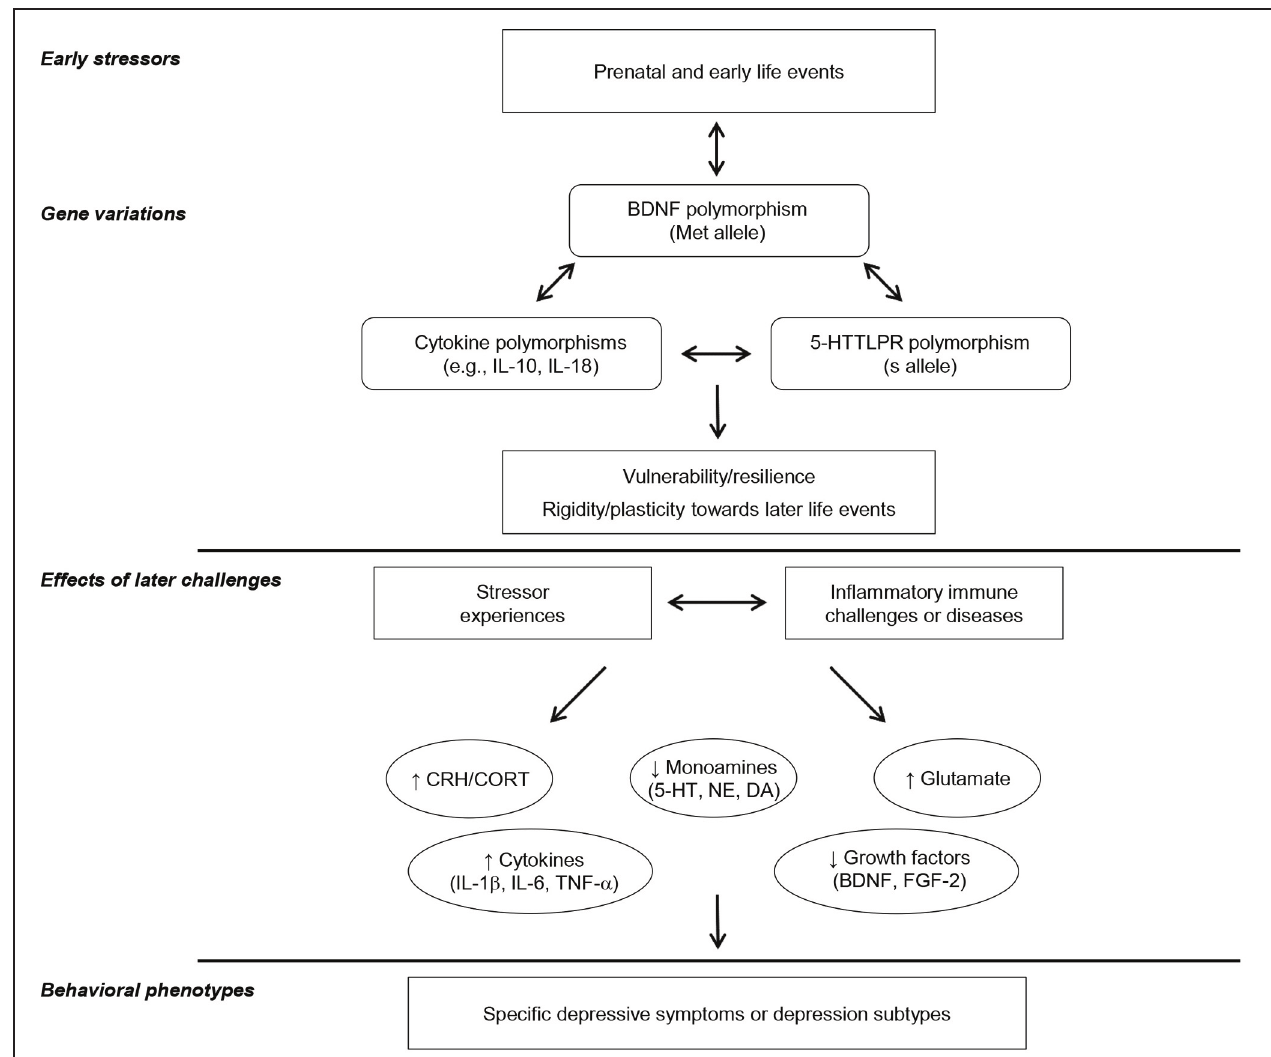
FIGURE 1 | This provides a schematic representation of the potential interactive influence of prenatal, childhood, and/or adulthood events and particular genetic variations in affecting inflammatory and growth factors, ultimately leading to specific depressive illnesses. It is suggested that particular gene polymorphism, including that of the growth factor BDNF, may influence vulnerability versus resilience to the emergence of depression, and that this may be moderated by the presence of adverse childhood experiences. In this regard, gene polymorphisms are not seen as necessarily being related to positive or negative outcomes, but instead presence of